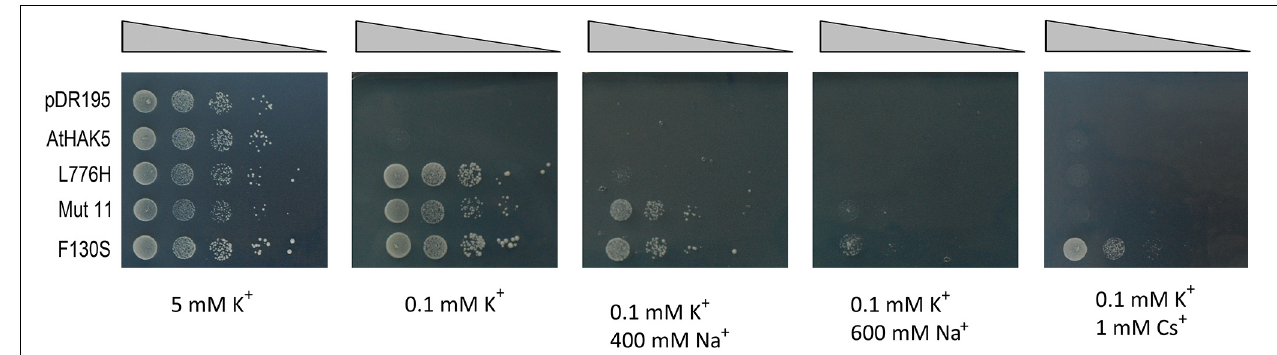
Mut11 (L776H, F130S) and F130S were used for growth assays on drop tests on solid media. Serial dilutions of cell suspensions were plated on minimal AP media supplemented with the indicated K + , Na + and Cs + concentrations.